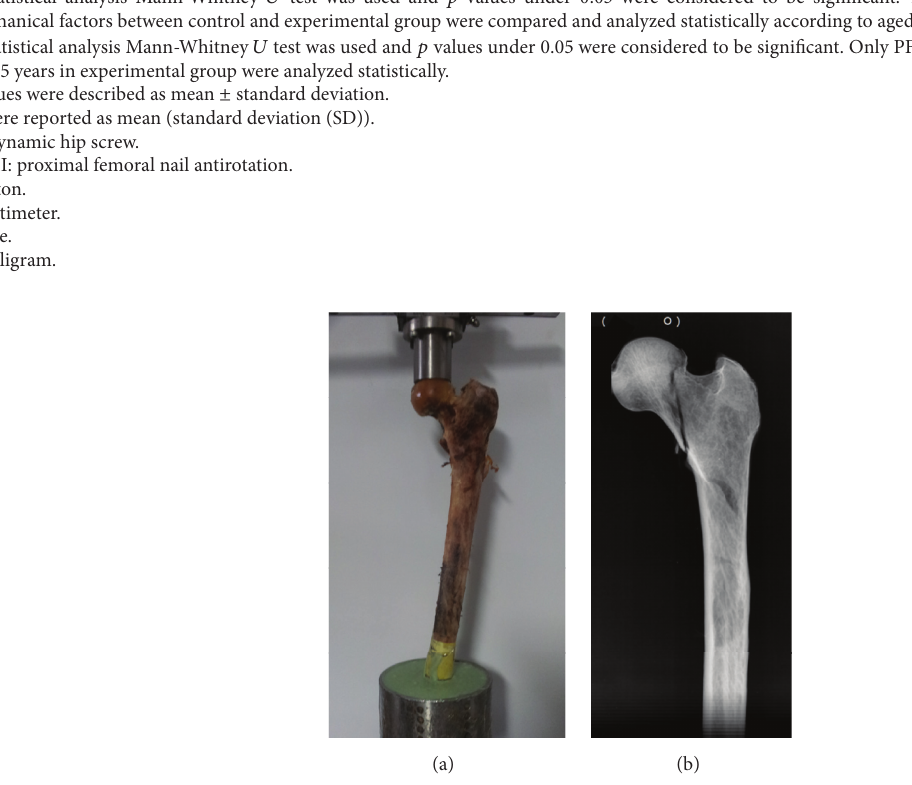
Figure 6: (a) Clinical photograph of a fracture following application of a static compression load to a specimen that did not undergo any procedures (control group). (b) Anteroposterior radiograph of the proximal femur revealing a femoral neck